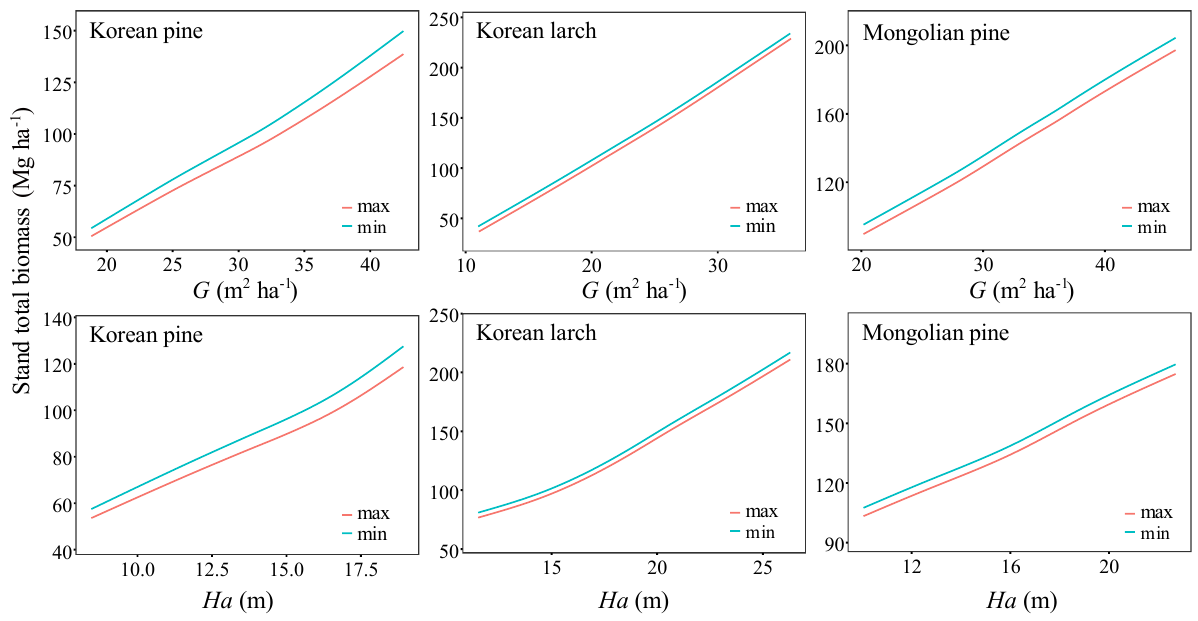
Figure 8. Stand biomass prediction curves under two climate gradients by three conifer species. The curves of red and green represent the increasing climate by the gradient (minimum and maximum).